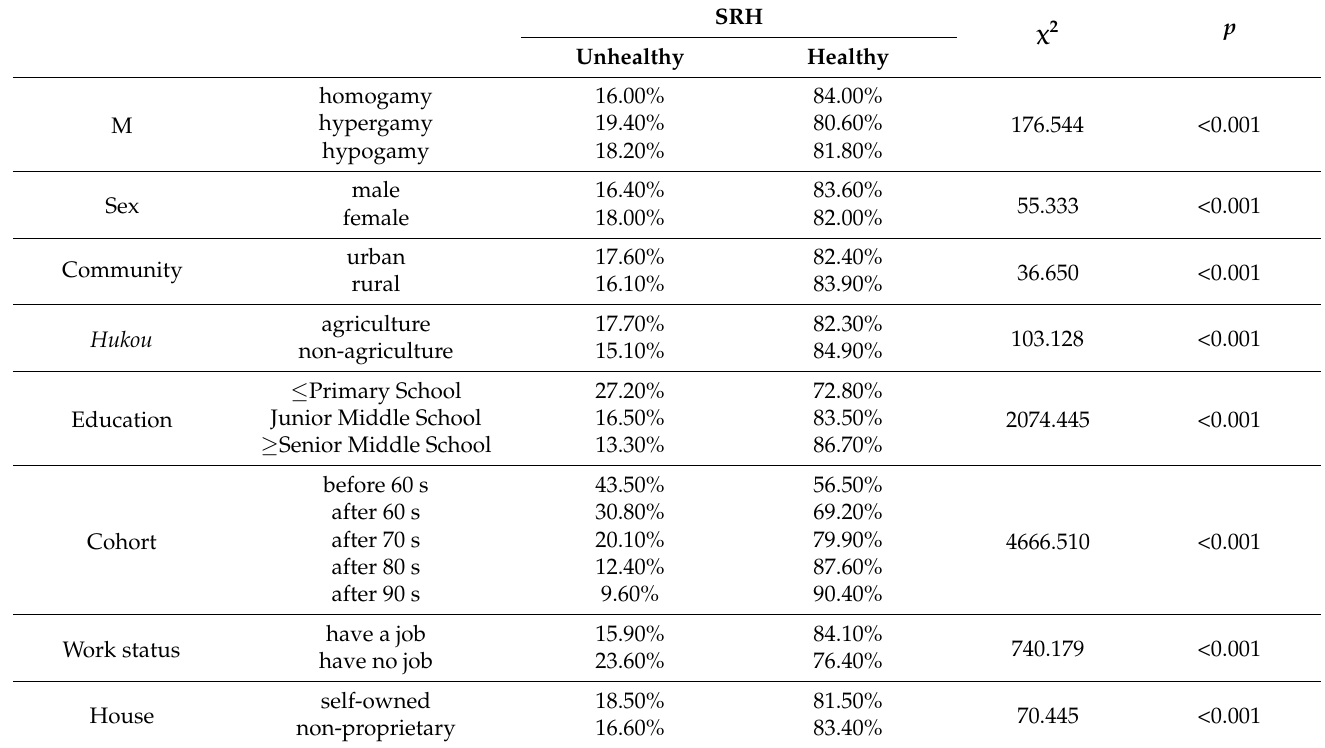
Table 4. SRH of different internal migrants (N =